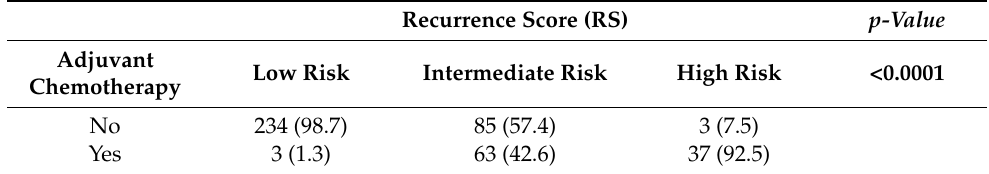
Table 4. Association between recurrence score and decision to have adjuvant